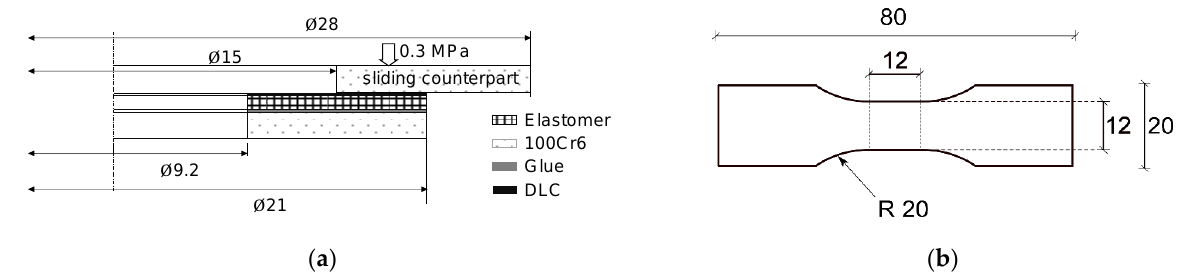
Figure 1. ( a ) Friction pair consisting of a test sample (DLC coated elastomer or elastomer) glued onto a 100Cr6 steel ring. A second steel ring acts as sliding counterpart. Only one half of the cross section is shown. ( b ) Dimensions of the tensile test specimens.